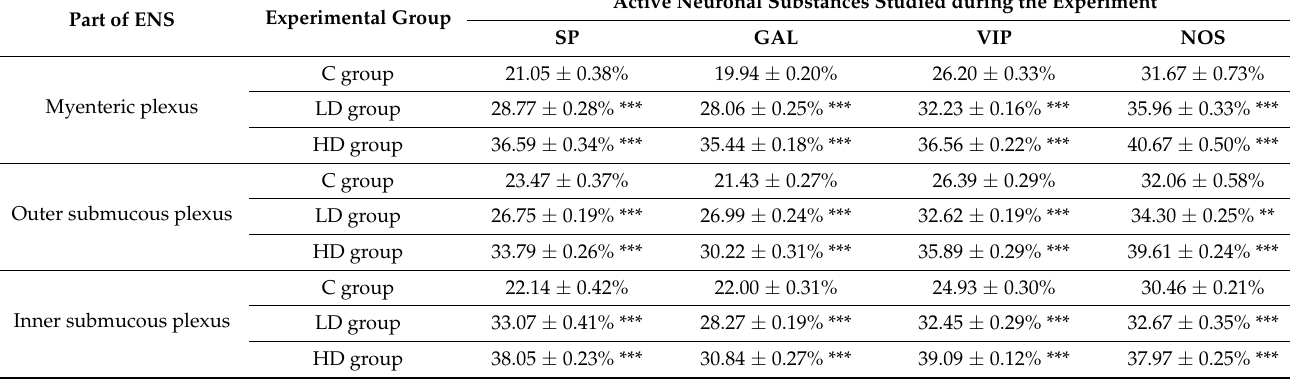
NRG1-positive neurons were considered as representing 100% for all combinations with selected neuronal factors, and all the values presented are percentages (means ± SEM) of NRG1-positive enteric neurons. Highly statistically significant ( p ≤ 0.01 and p ≤ 0.001) differences between the C group and LD group, as well as the C group and HD group, are marked with ** and ***,